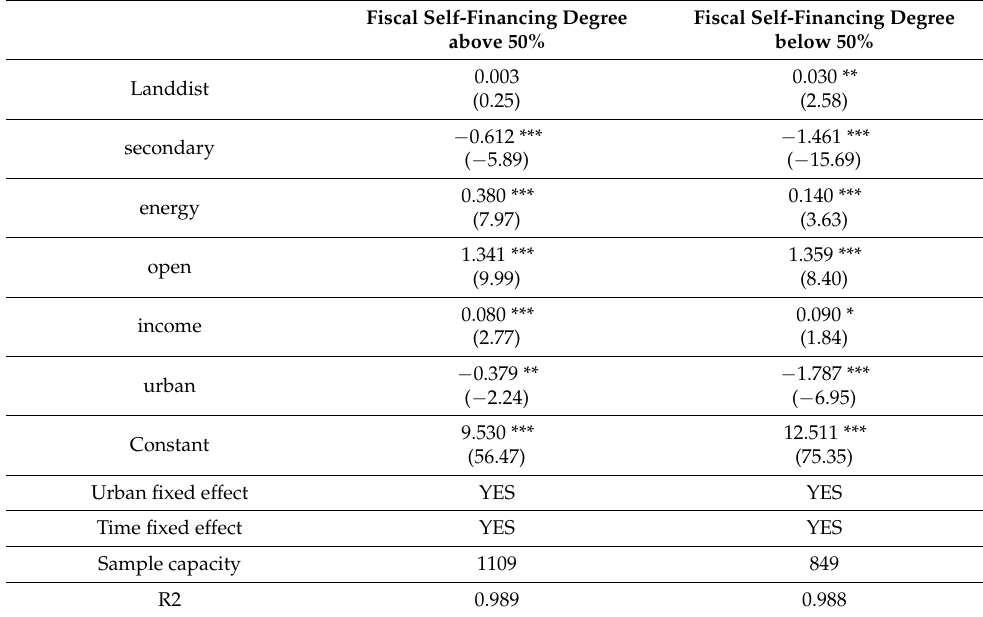
Table 6. Estimation results of sub-fiscal self-sufficiency